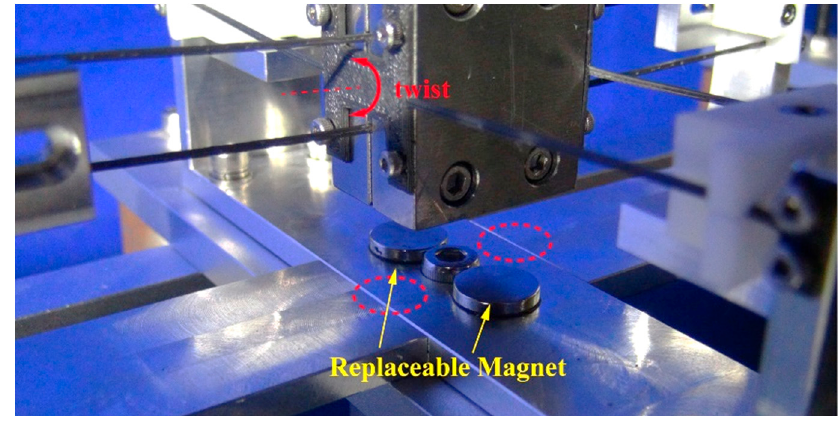
Figure 19. Layout of the symmetric magnets.